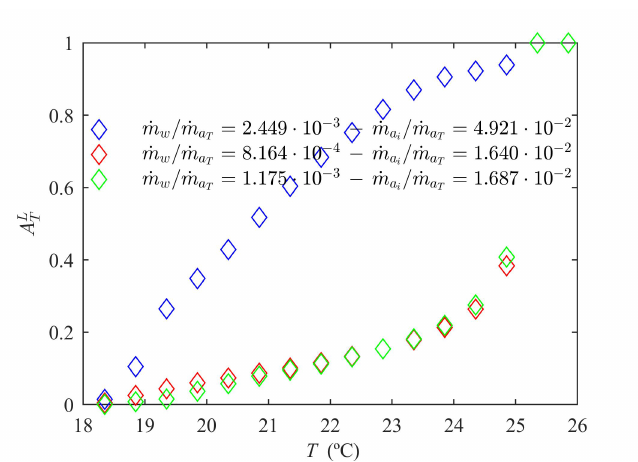
Figure 10. Variation of A L as a function of the air temperature for three representative T